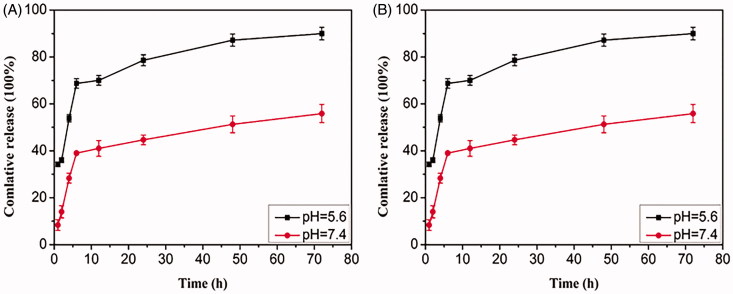
pH-responsive release profiles of DNM from (A) Fe3O4@mSiO2-DNM and (B) Fe3O4@mSiO2-DNM-ZnO NPs delivery systems at pH 7.4 and 5.6 at 37 °C.